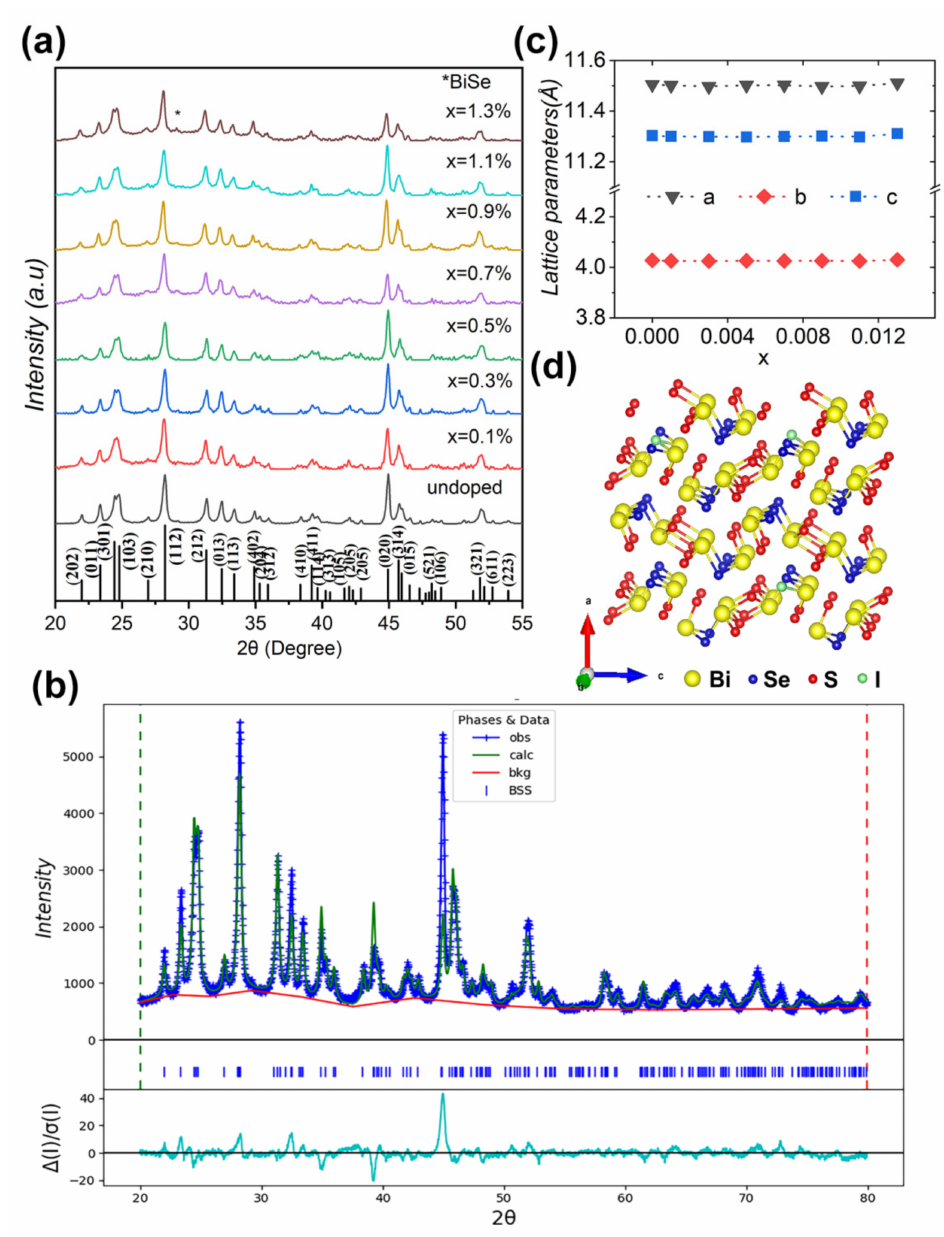
Figure 1. ( a ) XRD patterns for Bi 2 Se 1 − x I x S 2 (x = 0–1.3%). The asterisk represents the impurity peak of BiSe. ( b ) Rietveld refinement analysis from XRD patterns of Bi 2 SeS 2 , where obs represents observed, calc is calculated, bkg is background, and diff is the residual difference between the curves. ( c ) Variation of lattice parameters with the doped amount x. ( d ) Crystal structure along the a -axis for the iodine doped Bi 2 SeS 2